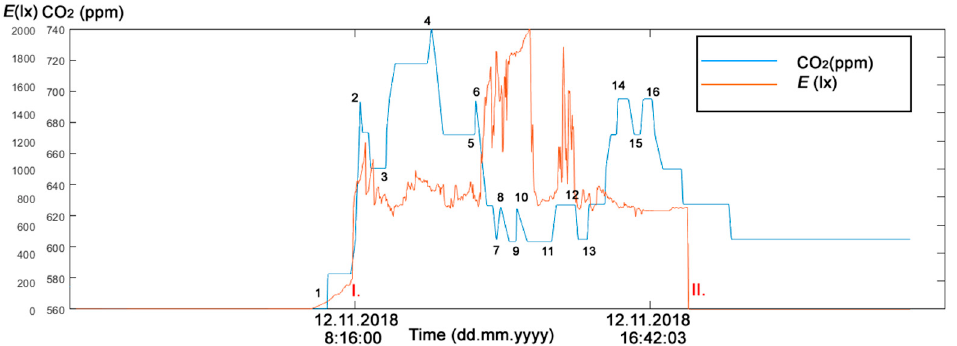
Figure 5. The reference (measured) CO 2 concentration course and Illuminance E (lx) course (12 November 2018) in room R203 in Smart Home Care (SHC) for Activities of Daily Living (ADL) monitoring. (1) arrival (12 November 2018 7:33:00), (2) departure (12 November 2018 8:28:11), Time of Person Presence (TPP) ∆ t 1 = 0:55:11; (3) arrival (12 November 2018 09:12:52), (4) departure (12 November 2018 10:29:16), TPP ∆ t 2 = 1:16:24; (5) arrival (12 November 2018 11:41:55), (6) departure (12 November 2018 11:44:18), TPP ∆ t 3 = 0:02:23. (7) arrival (12 November 2018 12:18:04), (8) departure (12